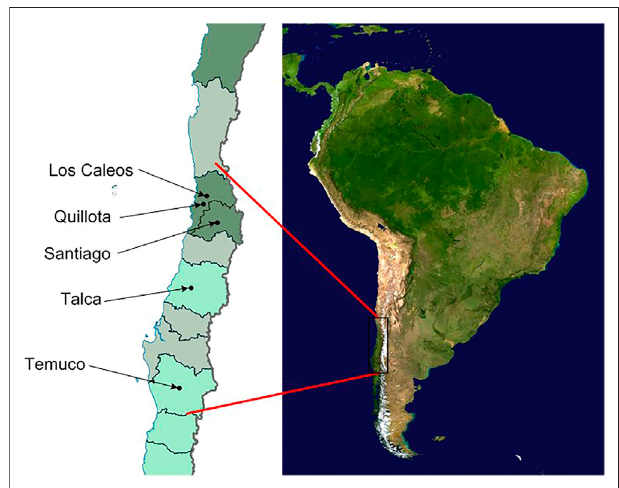
FIGURE 1 | Map of Chile with the location of the monitoring